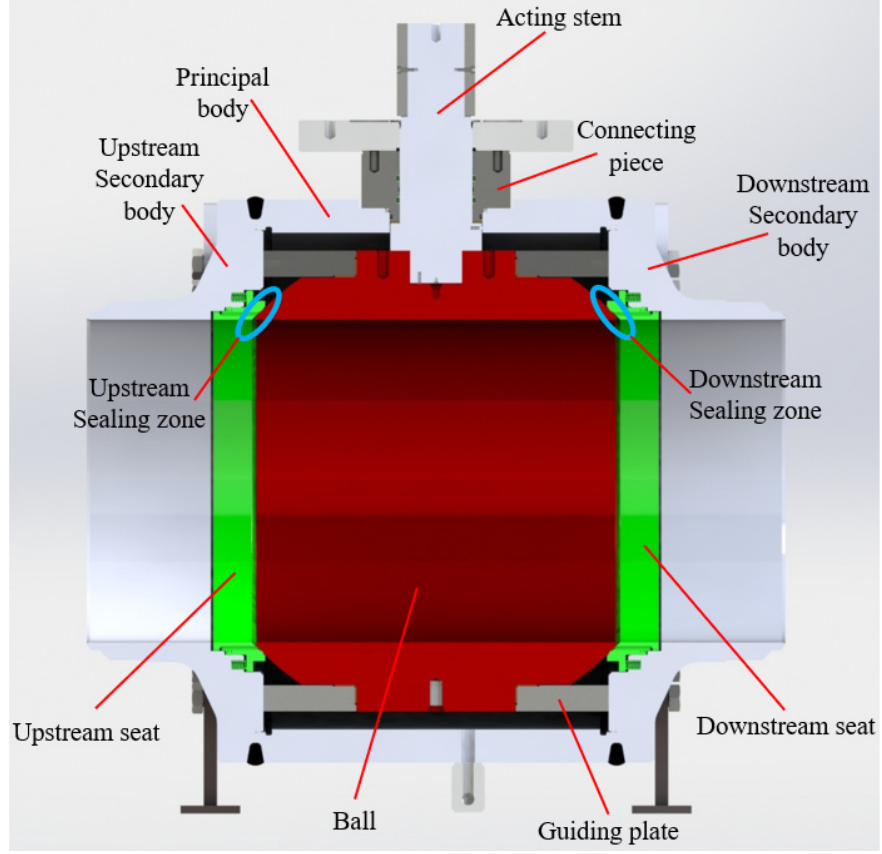
Figure 1. Ball valve components (front section).